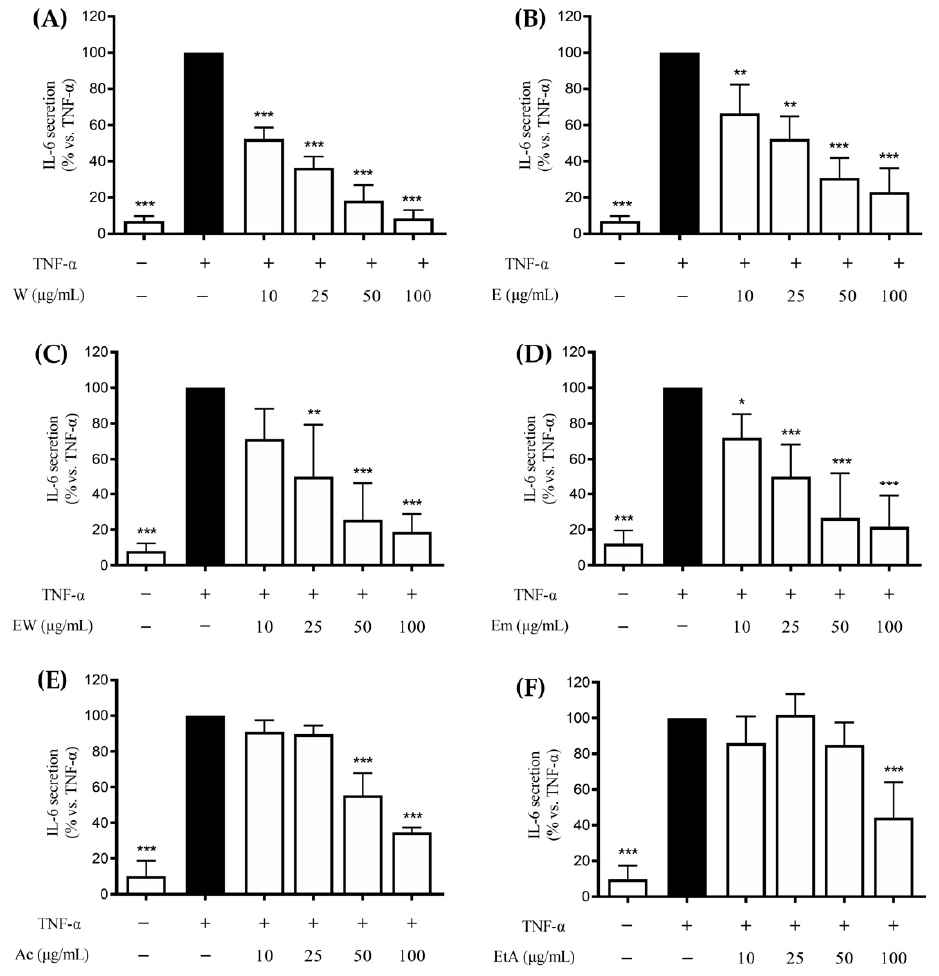
Figure 2. Effects of Rhus coriaria L. extracts (( A ) 100% water (W), ( B ) 100% ethanol (E), ( C ) ethanol– water (ethanol:water 50:50 v / v , EW), ( D ) ethanol macerated (plant material subjected to maceration with pure ethanol for 48 h, Em), ( E ) acetone (Ac), ( F ) ethylacetate (EtA)) on the TNF- α (10 ng/mL) challenged GES-1 cells (6 h). The release of IL-6 was assessed through an ELISA assay. The reference compound (black color) used was EGCG 20 µ M ( − 24%). Data are reported as percentage in compari- son to the stimulated control, which was arbitrarily assigned to 100% value. * p < 0.05, ** p < 0.01, *** p < 0.001 versus TNF- α . IL-6,